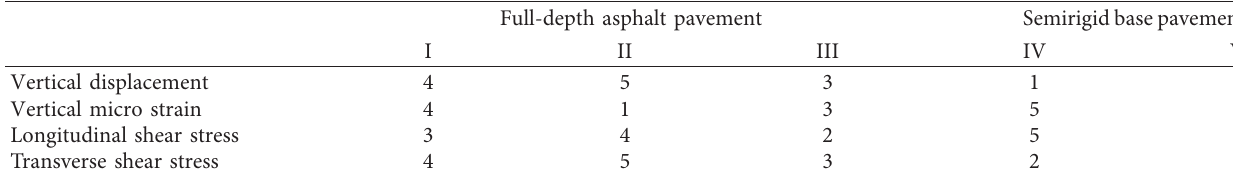
Figure 10: Time history curve of each index of five structures. (a) Time history curve of vertical displacement of the road surface. (b) Time history curve of vertical stress of road surface. (c) Time history curve of the vertical micro strain of road surface. (d) Time history curve of longitudinal shear stress of road surface. (e) Time history curve of transverse shear stress at the bottom of the lower surface layer. Table 2: Ranking of indicators of five structures.